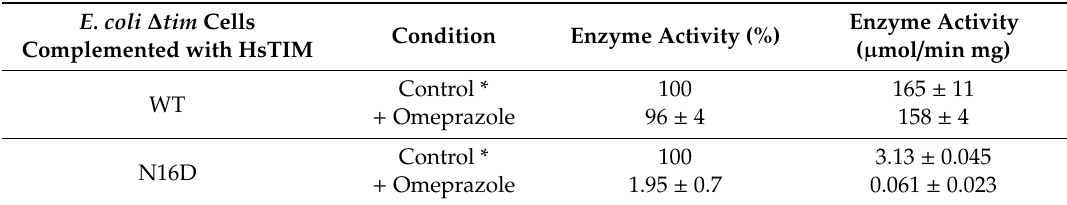
Table 2. Triosephosphate isomerase (TIM) activity in E. coli ∆ tim cells complemented with WT and N16D HsTIM.